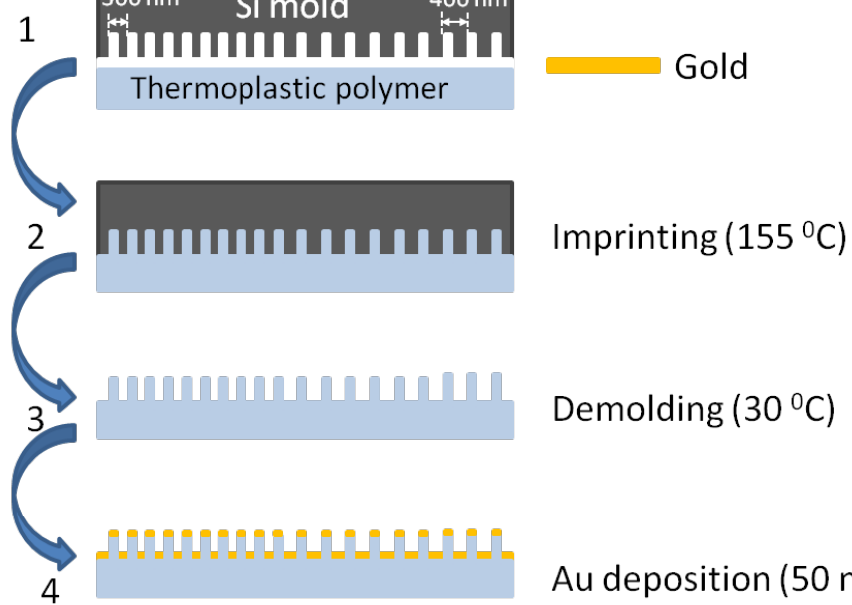
Figure 1. Schematic steps of the nanoimprint lithography process used for fabricating gold nanopost-shell arrays.